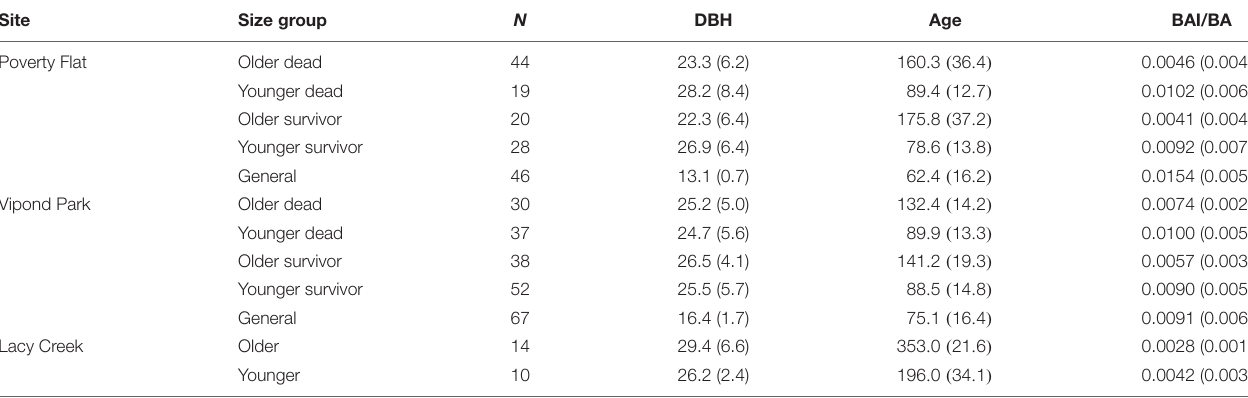
TABLE 5 | Mean (SD) diameter at breast height in cm (DBH, 1.4 m), relative age (number of rings at 1.4 m), and BAI/BA (basal area increment/basal area) for Pinus albicaulis by site and category.